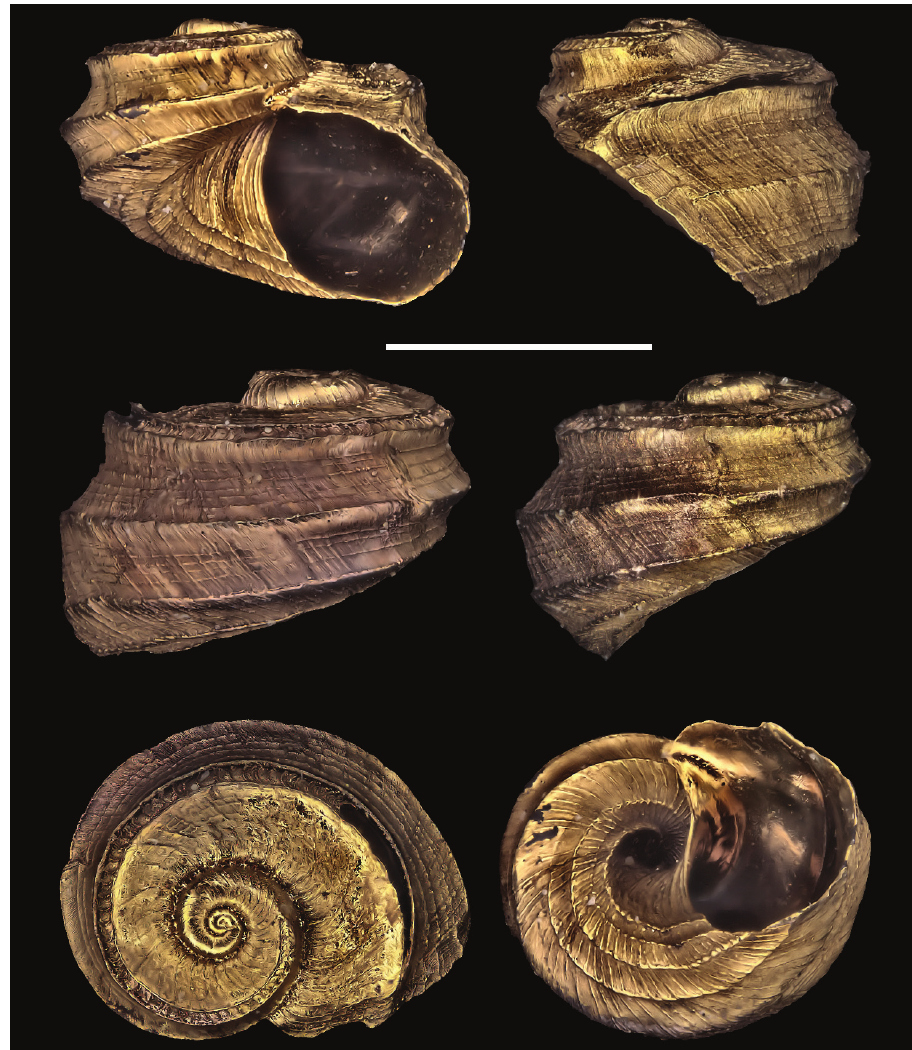
Figure 21. Sukashitrochus maraisi Herbert, 1986. Holotype T3271/NMSA-MOL 0D684. Scale bar: 1 mm.